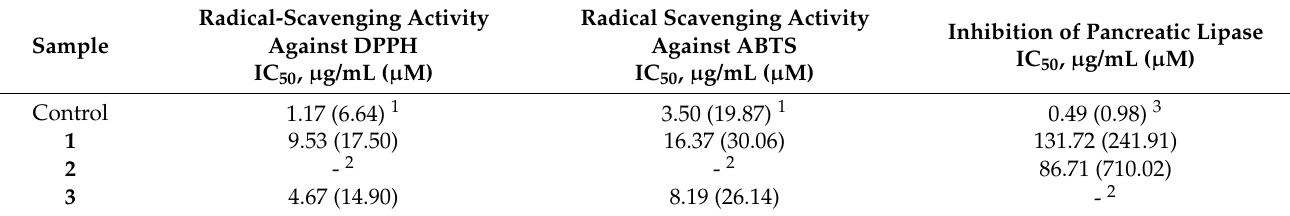
Table 4. Bioactivities of compounds 1 to 3